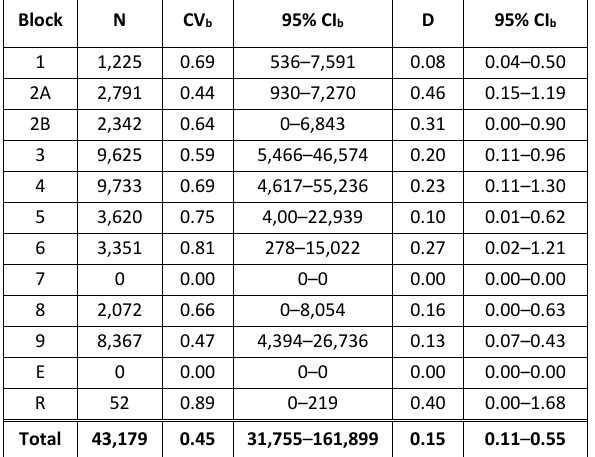
Table 2. Animal abundance (N) and density (D; Indiv/km 2 ) estimates by survey block and for the total area covered during the 2007 Icelandic aerial survey. Estimates of esw (incorporating g (0) ) taken from SCANS-II survey (Burt et al., 2006a; Hiby, 2006; Hammond et al., 2013). b =bootstrap.